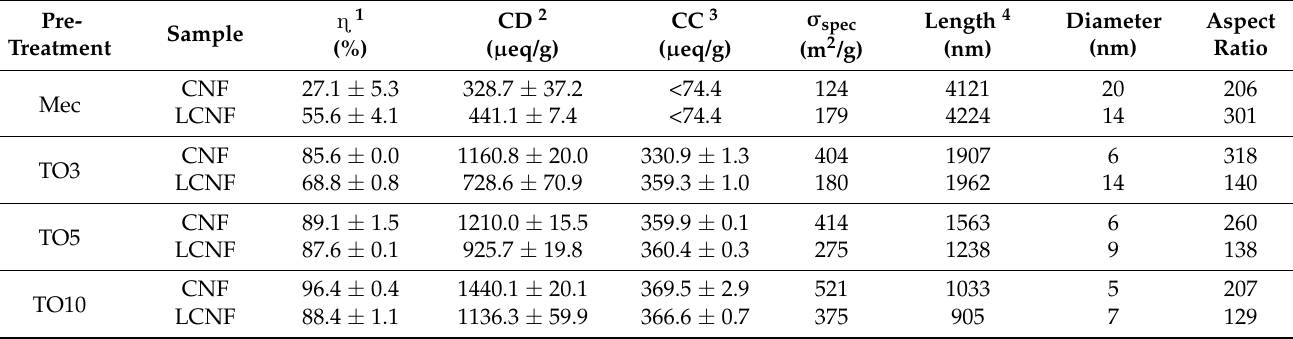
Table 2. Characterization of cellulose nanofibers (CNFs) and lignocellulose nanofibers (LCNFs) obtained from mechanical (Mec) and TEMPO-mediated oxidation (TO)